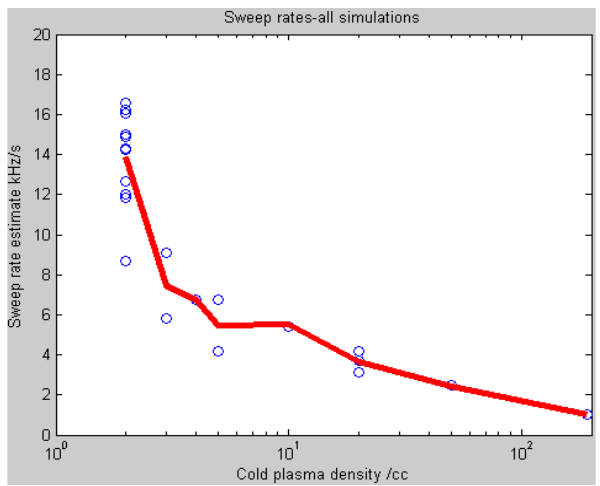
Fig. 22. The computer simulation sweep rates as a function of the cold plasma density. This figure presents the results from all the simulations carried out. The sweep rate of the chorus elements is a decreasing function of cold plasma density. Note that all these runs are at a constant degree of nonlinearity, and thus the saturation amplitude is itself a decreasing function of the cold plasma